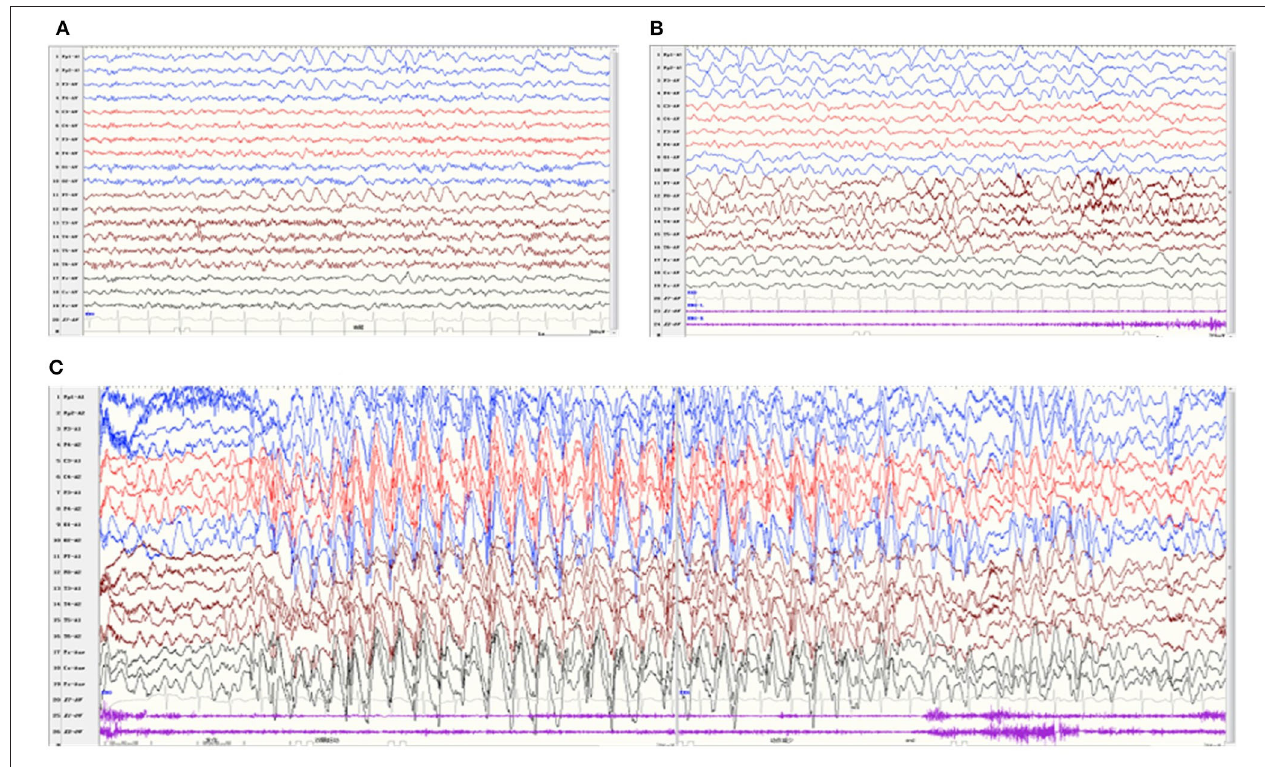
FIGURE 3 | Video-EEG of patient 6 at 22 months of age. The interictal EEG revealed continuous slow theta high-amplitude activity on the left hemisphere, and rapid β -wave dominance in the right hemisphere (A) . The ictal EEG showed a focal discharge originating from the left temporal region (B) . Video-EEG of patient 7 (C) . The ictal EEG revealed generalized paroxysmal high-amplitude 2-3Hz spike–wave discharges.